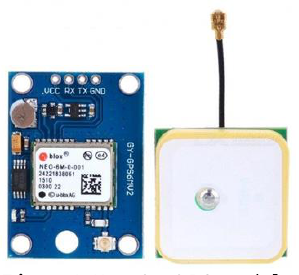
Figure 1. Neo-6m GPS module.